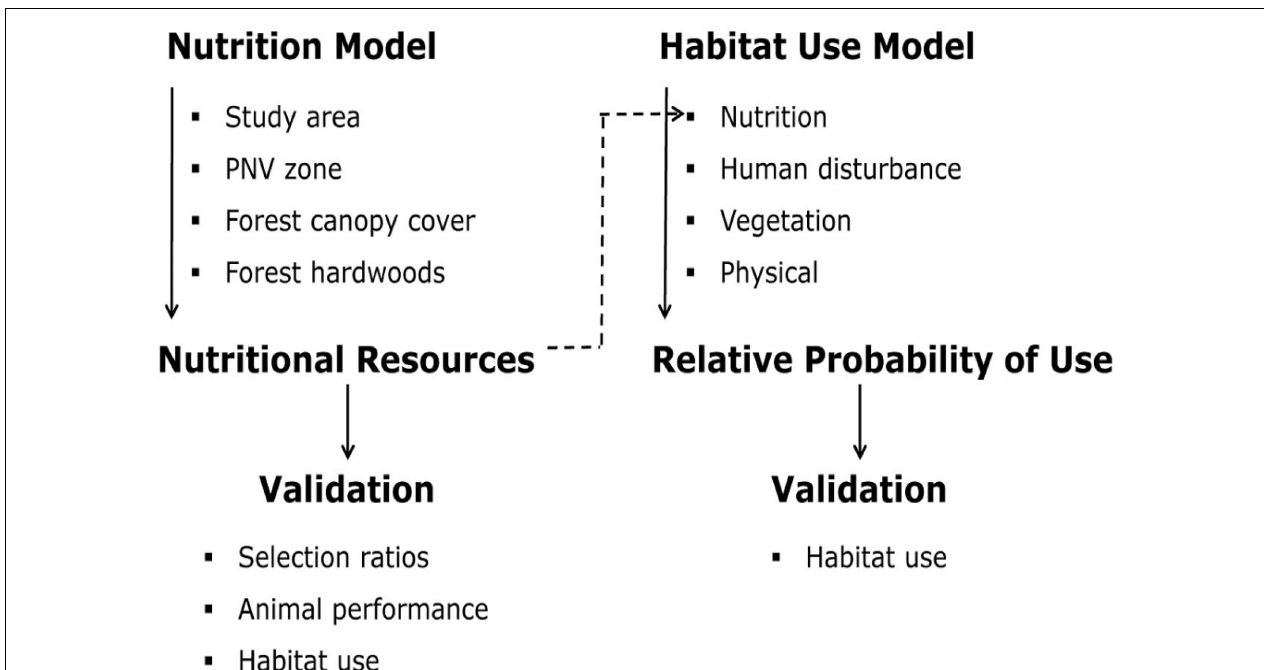
FIGURE 5 | Conceptual framework of nutrition and habitat-use models developed and validated for elk in western Oregon and western Washington, United States (from Wisdom et al., 2018a). Categories of covariates considered during model development and types of data used for validation are shown below each model or type of validation. Covariates in the nutrition model included study area and potential natural vegetation (PNV) zone as contextual covariates, and percent overhead canopy cover (forest canopy cover) and percent composition of hardwoods (forest hardwoods) as process covariates to predict dietary digestible energy (nutritional resources). Nutrition model predictions were most strongly influenced by canopy cover. Predictions of the habitat-use model were influenced by process covariates of nutrition (dietary digestible energy), human disturbance (distance to roads open to public motorized use), and vegetation (distance to cover-forage edges), and the contextual covariate percent slope (physical category). The two models were designed as complementary applications: the nutrition model identified the spatial arrangement and quality of nutritional resources, and the habitat-use model quantified the probability that areas of higher nutrition would be used by elk, given the influence of all covariates that best predicted spatial